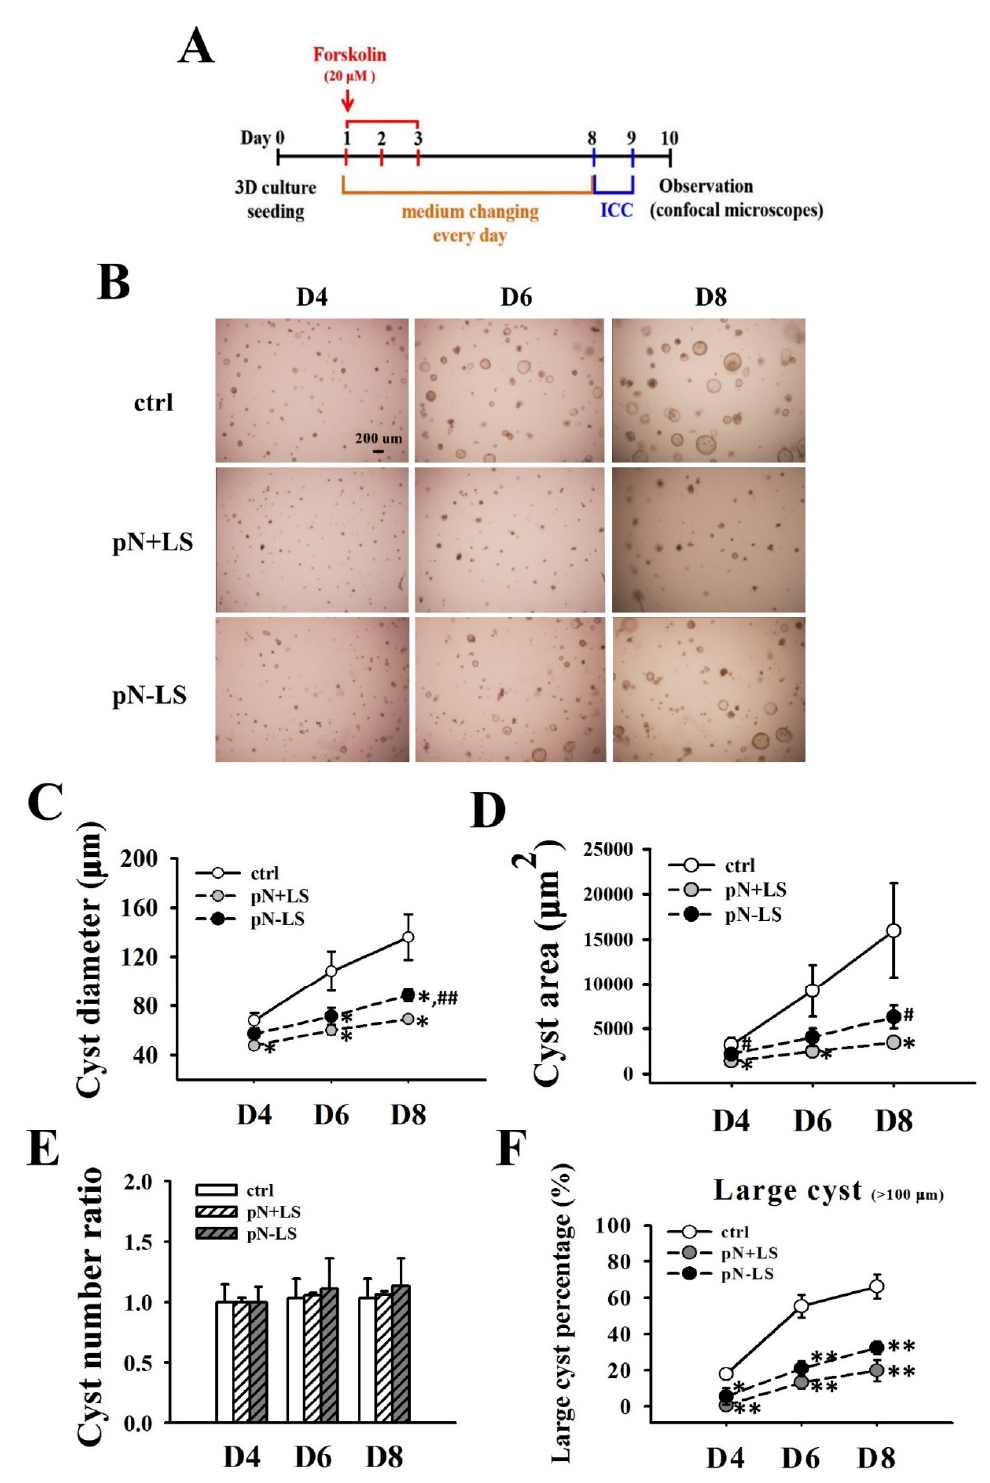
Figure 10. Effects of overexpression of mNGAL protein on cyst formation of 2L3 cells in 3D culture. ( A ) Timeline of cyst formation in 3D culture of the control group, pN + LS and pN − LS cells. ( B ) Repre- sentative images of cyst formation under the same view of the control group, pN + LS and pN − LS cells on Days 4, 6, and 8, respectively. Scale bar: 200 µ m. ( C ) Measurement of cyst diameters of the